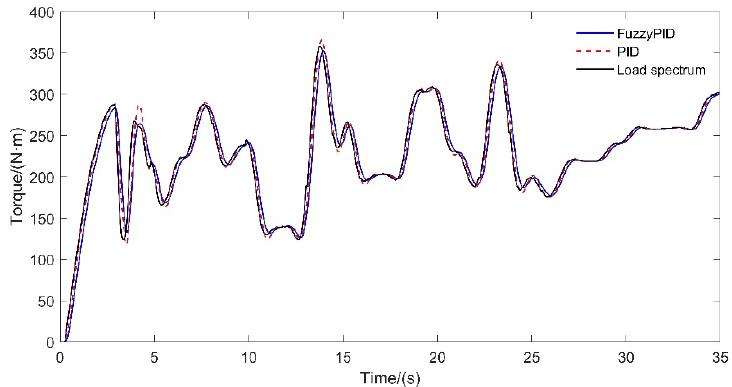
Figure 10. Simulation results of load spectrum loading.